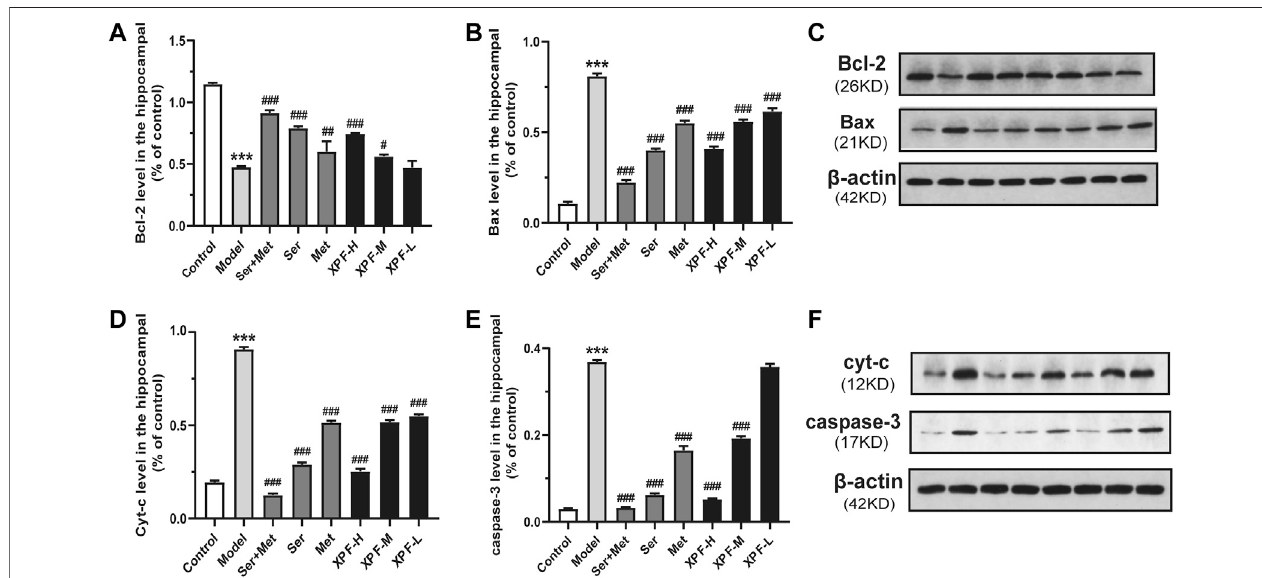
FIGURE 9 | Experimental validation of key targets Bcl-2, BAX, Cyt-c, caspase-3 in rat hippocampus induced by CUMS and ISO. (A) Quantitative analysis of Bcl-2 expression in the hippocampal. (B) Quantitative analysis of BAX expression in the hippocampal. (C) Western blot analysis of Bcl-2 and BAX protein. (D) Quantitative analysisofCyt-cexpressioninthehippocampal. (E) Quantitativeanalysisofcaspase-3expressioninthehippocampal. (F) WesternblotanalysisofCyt-candcaspase-3 protein. Data were presented as means ± SD ( n (cid:2) 3). *** p < 0.005 compared with the control group, ### p < 0.005 compared with the model group.